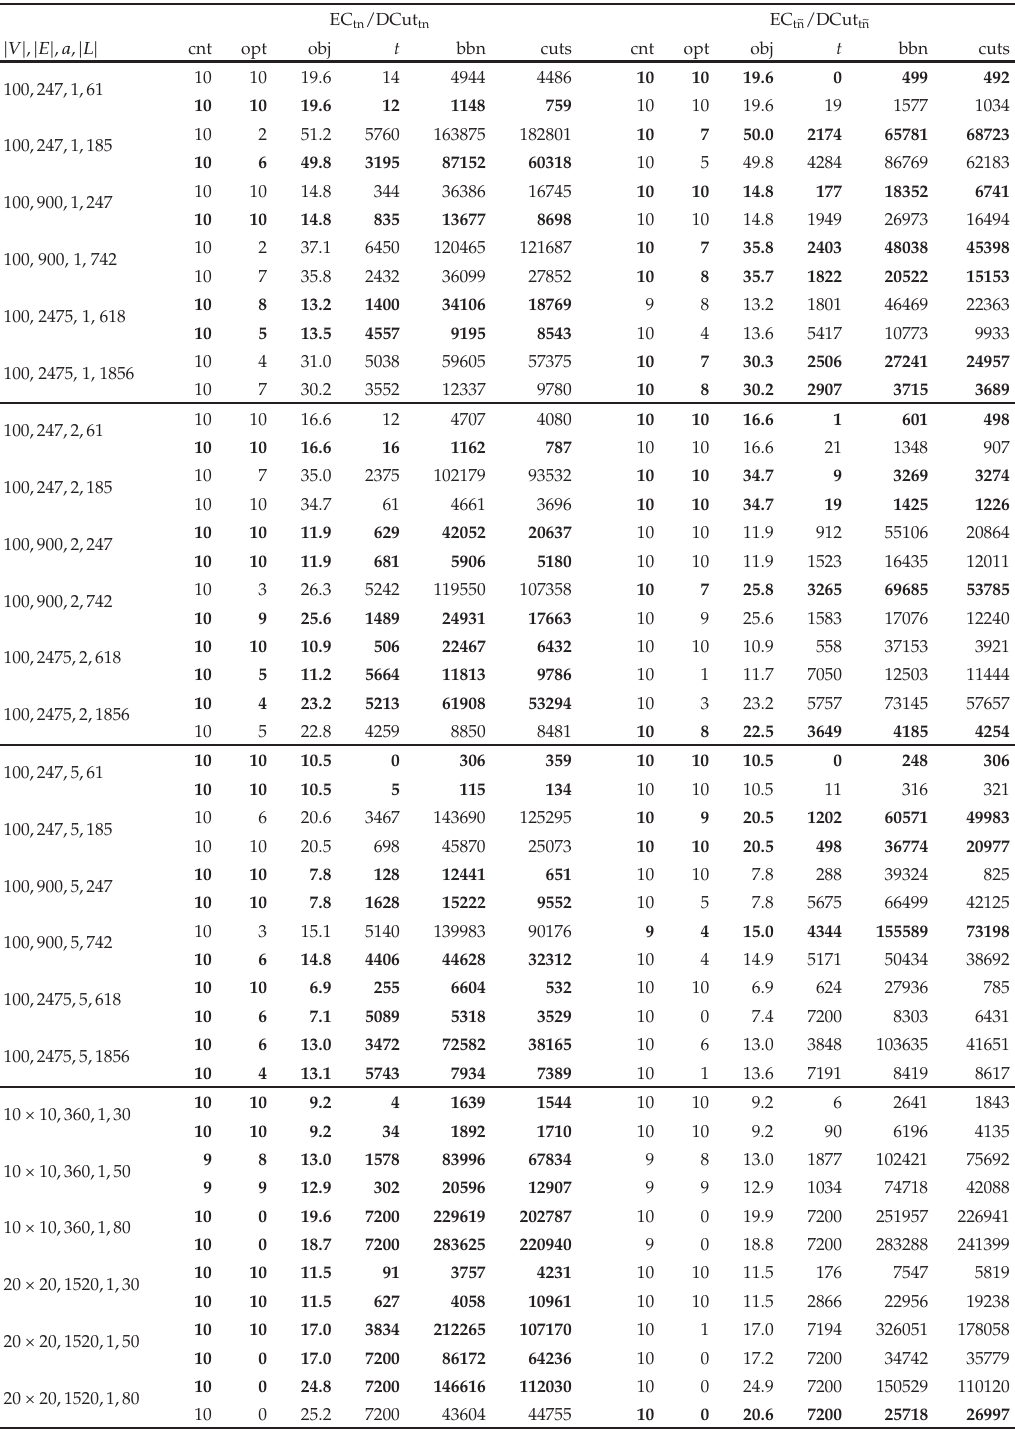
Table 8: Comparison of formulations EC t and DCut t with Inequalities (cid:2) 3.22 (cid:3) , indicated with index n , and with additional Inequalities (cid:2) 3.23 (cid:3) , indicated with index (cid:12) n